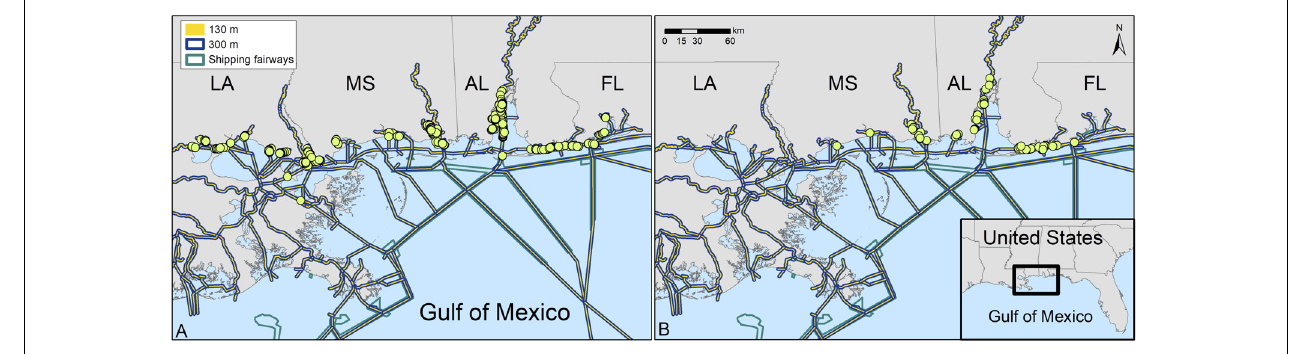
FIGURE 2 | Maps of the nGoM with boat channels and fairways and locations of tagged (A) and sighted (B) manatees in ship channels. TABLE 3 | Number of tagged and sighted manatees in 130 and 300 m boat channels and shipping fairways (FW) and percentage of detected or sighted individuals in each type of channel. Channel